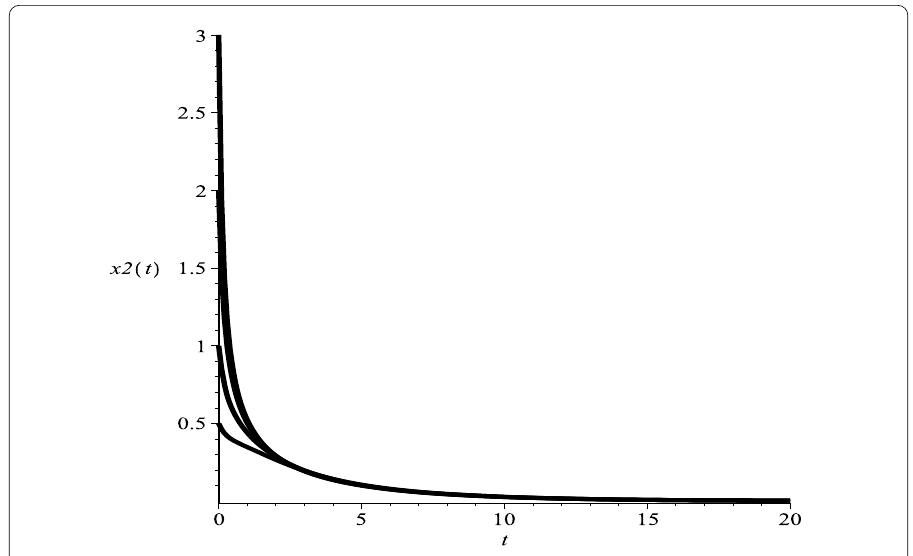
Figure 6 Dynamics behavior of the second component x 2 ( t ) of system (5.1); here we take k = 0.2 and the initial conditions ( x